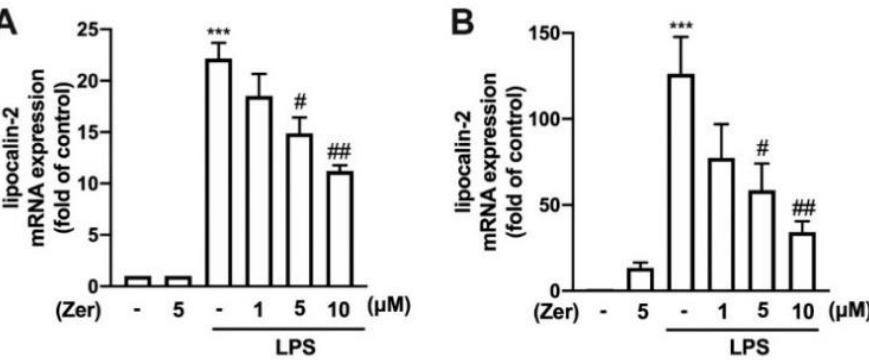
Figure 1. Inhibitory effects of zerumbone on the expression of lipocalin-2 in macrophages and microglia. RAW264.7 macrophages ( A ) and IMG adult mouse microglial cell lines ( B ) were supple- mented with different concentrations of zerumbone (1, 5, or 10 µ M) for 30 min and administered with lipopolysaccharide (LPS; 50 ng/mL) for 6 h. Lipocalin-2 mRNA expression levels were determined using real-time PCR and normalized to β -actin. Data are presented as the mean ± standard error of the mean (SEM) ( n = 3 or 4). *** p < 0.005 compared with the control group. # p < 0.05, ## p < 0.01 compared with the LPS alone group.